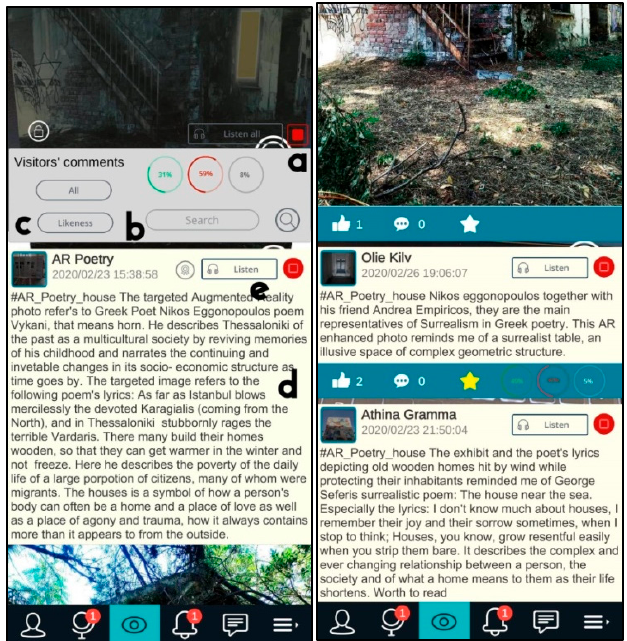
Figure 12. Read/listen to other visitors’ shared content about the targeted exhibit screen. Its key features are: ( a ) the ‘listen to all’ button, which narrates the text content of the shared posts, ( b ) the search input field, where a visitor can filter posts by keywords, ( c ) the likeness button, which orders posts by their popularity, ( d ) uploaded posts, and ( e ) ‘listen to a specific post’ button.